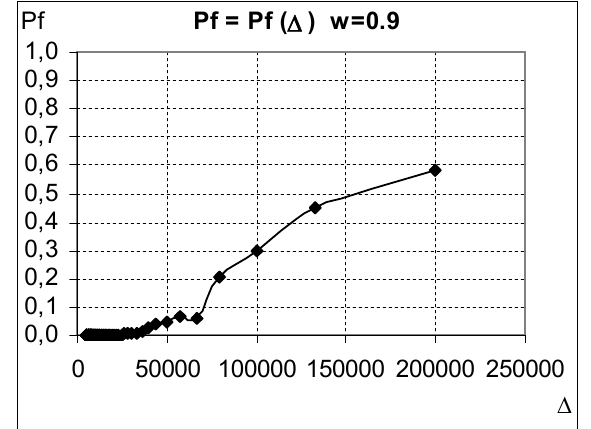
Fig 8. Failure probability in the case of m ≠ 2 for the non- corroded specimens with specified life = 400000 cycles Pf = Pf ( D ) w=0.9